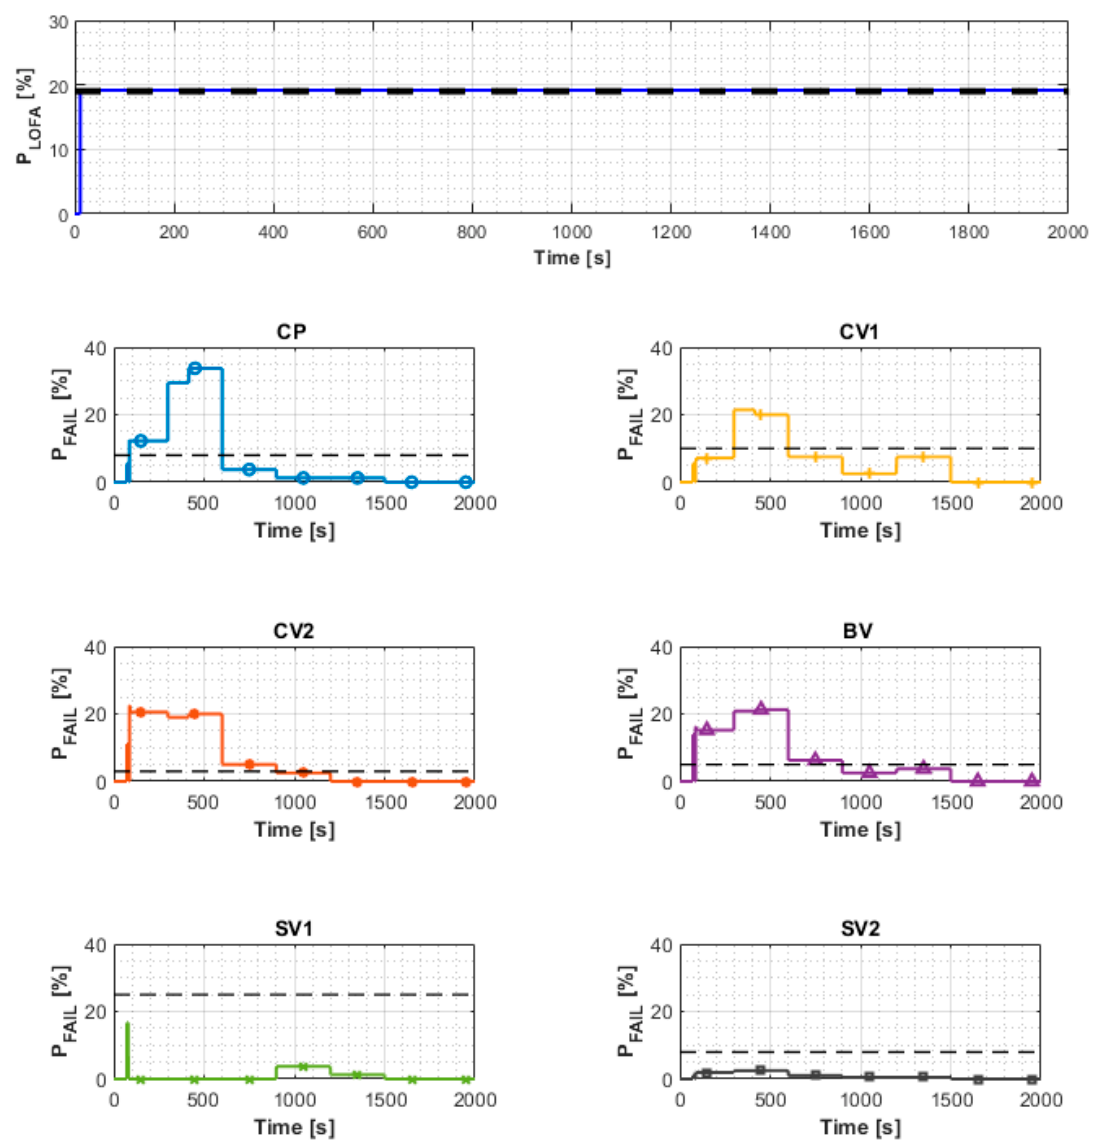
Figure 15. Values of P LOFA , l , j (top) and P FAIL , l , j ( e ) (six bottom plots) for scenario “partial closure of BV at 0 s, CP speed at 75% at 1 s, complete closure of CV2 at 71 s and complete closure of CV1 at 72 s” (continuous lines) compared with their limits P LOFA , lim and P FAIL , lim ( e ) (dashed